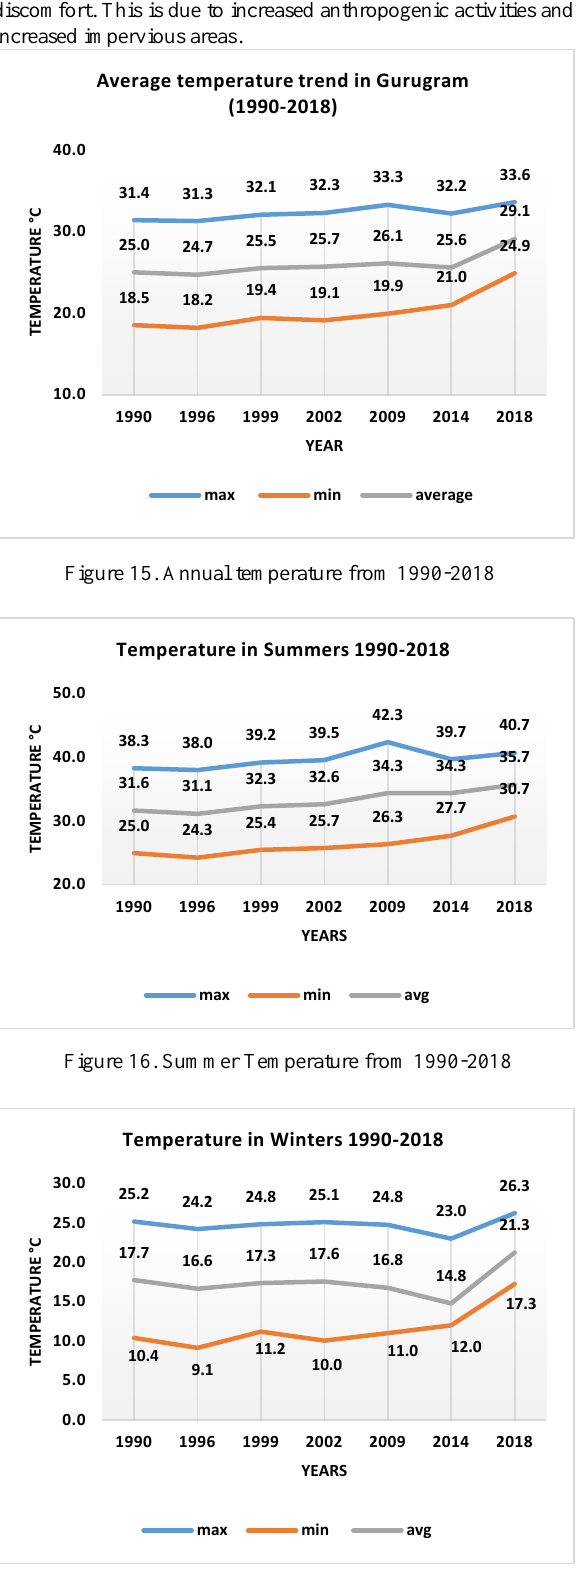
Figure 17. Winter Temperature from